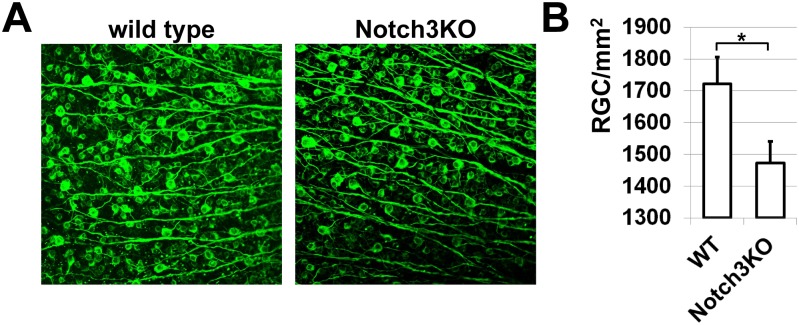
Notch3 deficiency results in reduced ganglion cell numbers in the retina.
A) Confocal images of flat-mounted retinas from Notch3 knockout (Notch3KO) animals and wild type (WT) littermates were collected. RGCs were labeled with beta III Tubulin antibodies for counting. B) Numbers of RGCs were compared between Notch3KO and WT animals. Values are means ± SEM (*P < 0.05, n = 10 eyes).